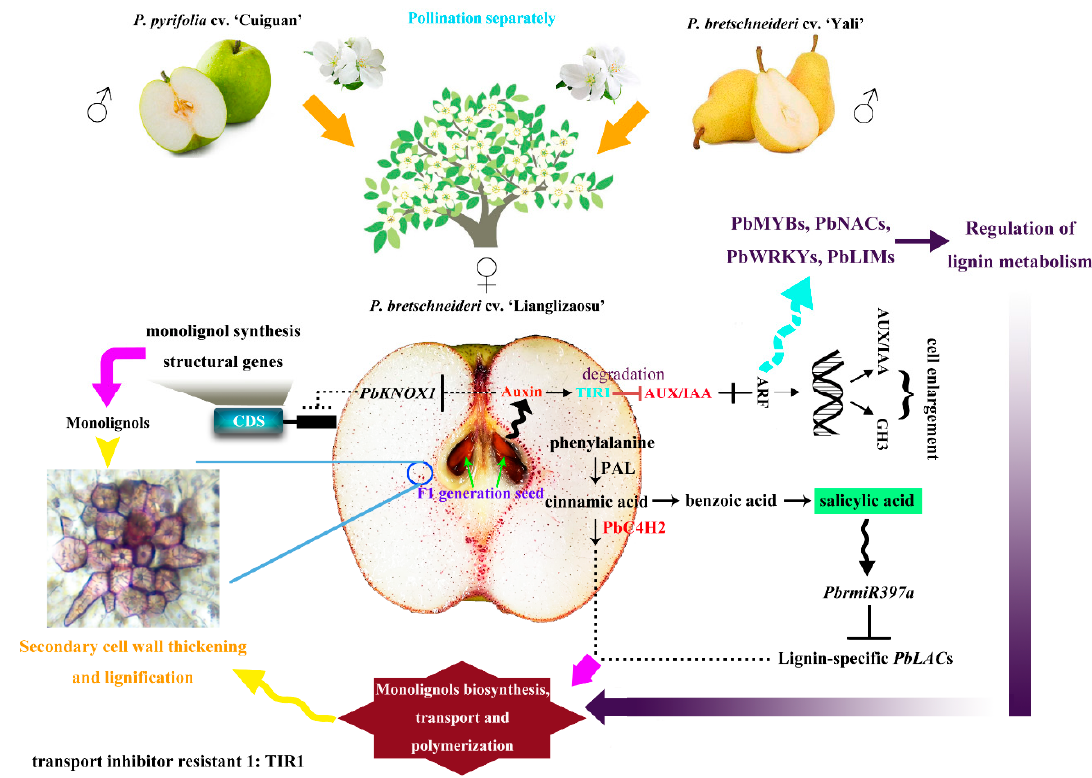
Figure 12. Hypothetical model of the effect of metaxenia on stone cell development and lignin metabolism in pear fruit.